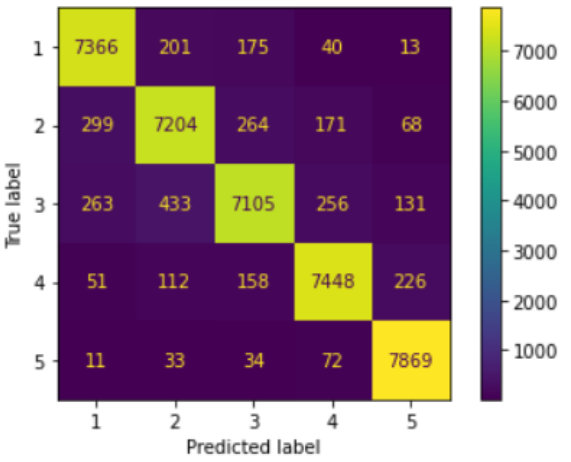
Figure 4: Confusion matrix illustrating true versus predicted label